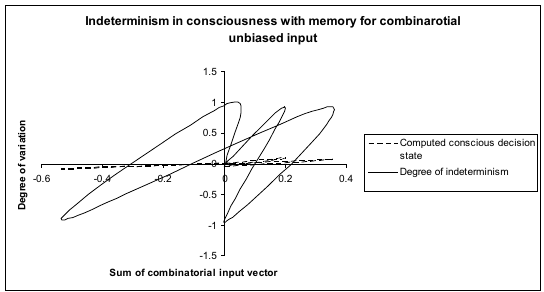
Fig. 20. Variation of state of consciousness in system with memory (fair C2).